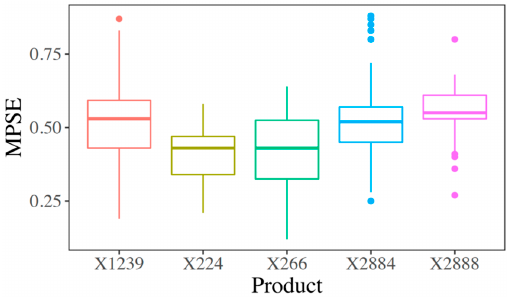
Figure 5. Boxplots of some products to be improved.